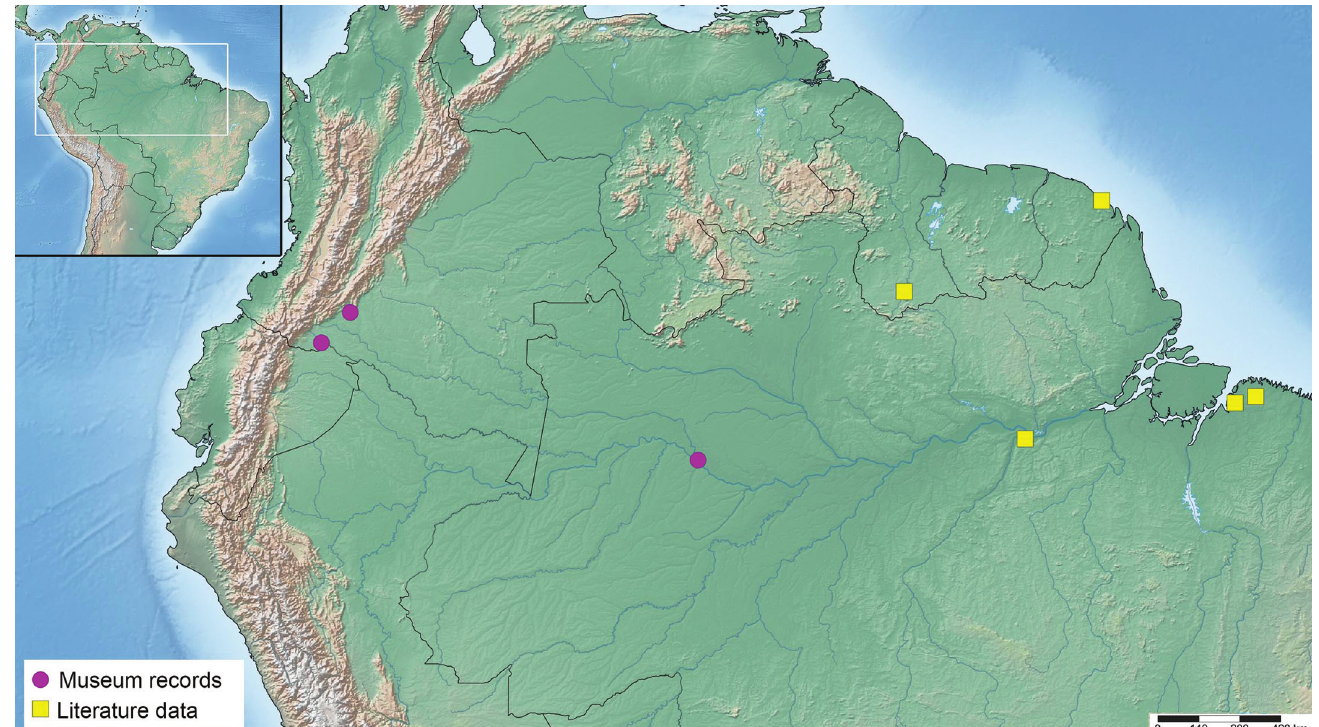
Fig. 13. Eomorphopus granulatus